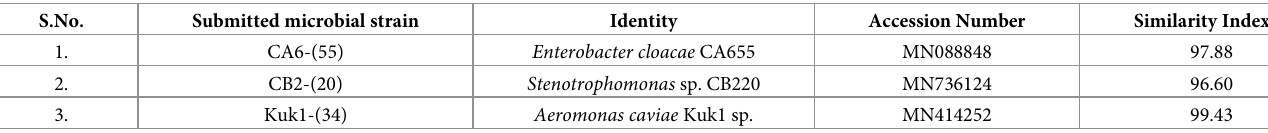
Table 4. 16S rRNA identification of positive